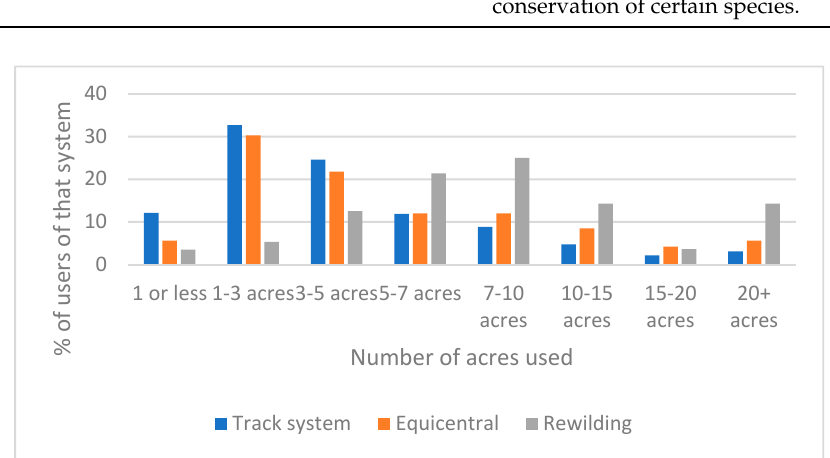
Figure 1. The acreage used by proponents of track, rewilding and Equicentral